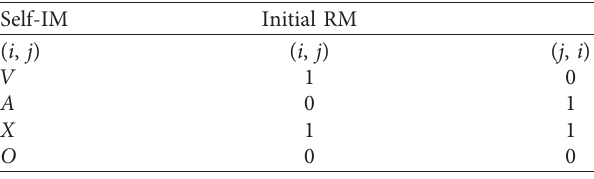
Table 1: Substitution rule.